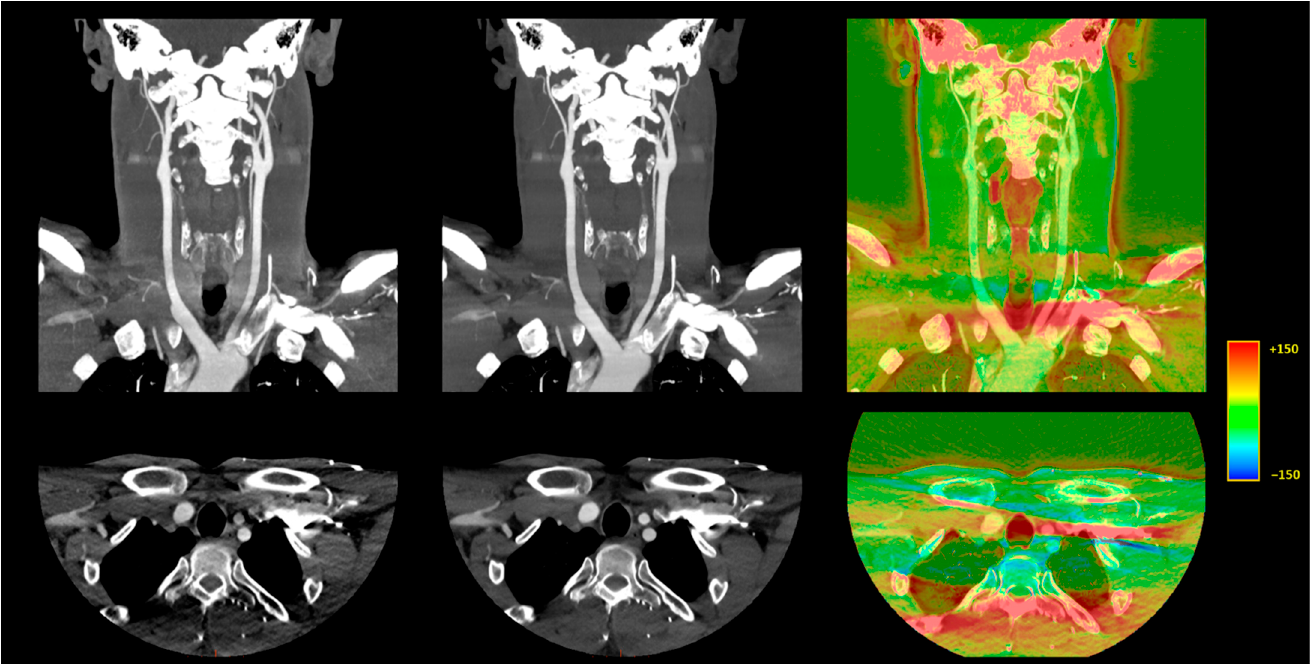
Figure 4. Illustration of the differences between DLR and H-IR for the vascular regions close to the aortic arch. A 10 mm, maximum intensity projection, coronal CT reconstruction ( top row ) and 1-mm axial CT reconstruction ( bottom row ). Left : AIDR 3D, hybrid iterative reconstruction. Middle : AiCE, deep learning-based reconstruction. Right : Color-mapped subtraction [AiCE-AIDR 3D] layered on the DLR image to visually highlight the differences between the two reconstruction techniques.